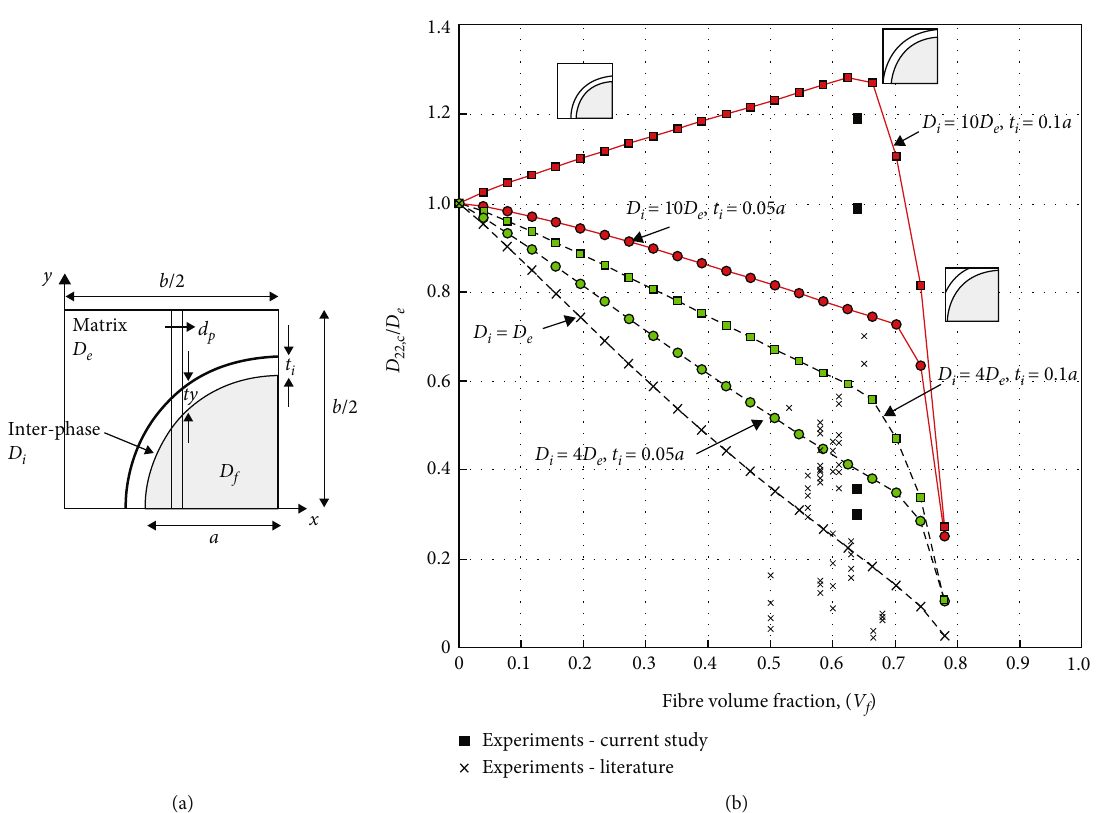
Figure 7: (a) Repeating element of a composite with an interphase region and (b) transverse di ff usivity values as a function of interphase , and di ff usion, D properties (thickness, t i i